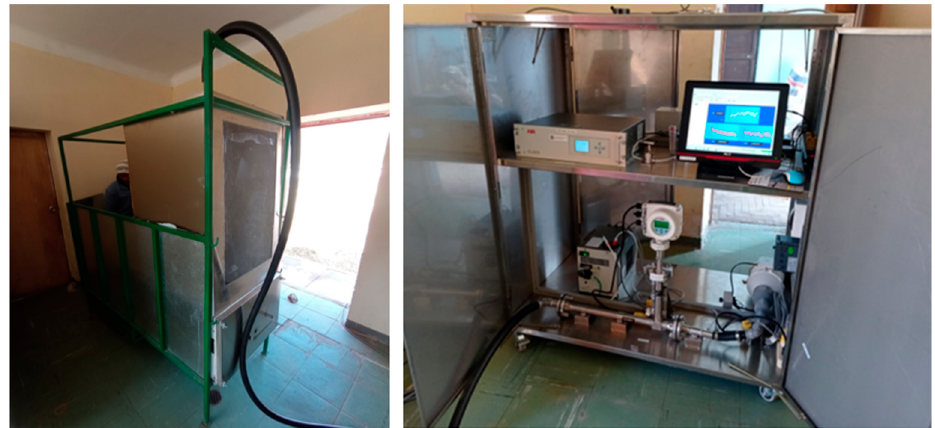
Figure 1. Mobile open-circuit respirometry system used for alpacas in the present study. The head hood is attached to the front structure of the metabolism crate.